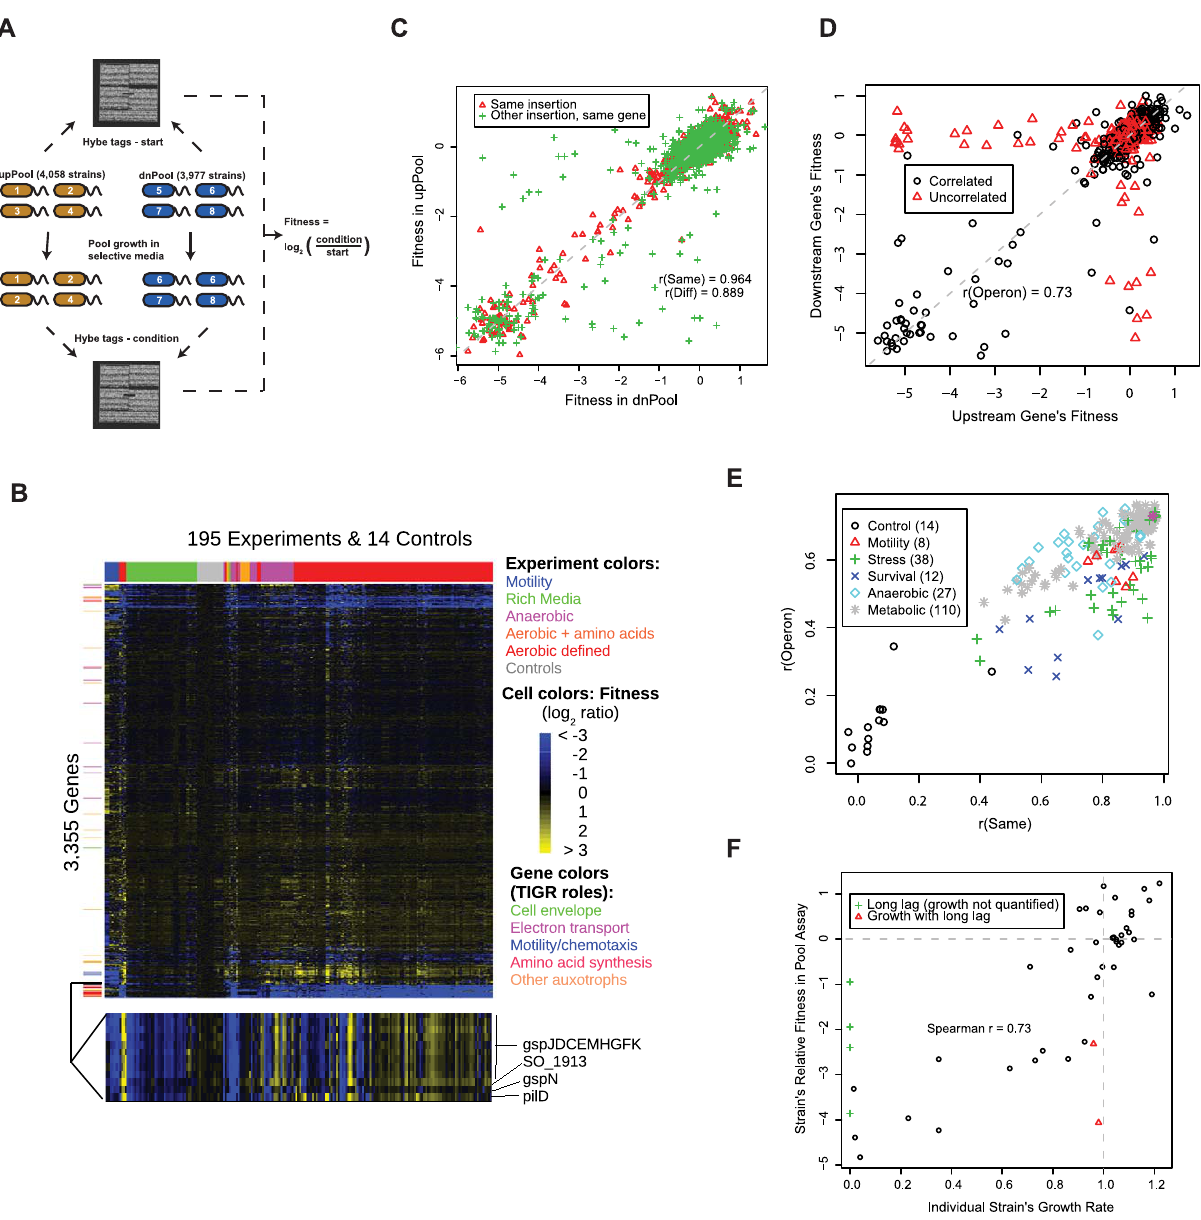
Figure 1. A S.oneidensis MR-1 mutant fitness compendium. (A) Parallel analysis of MR-1 mutant pools using TagModules. Only the uptags are used to interrogate strain abundance in the upPool, while the downtags are used exclusively to measure strain abundance in the dnPool. The Affymetrix TAG4 microarray illustrated here contains the complement sequences to both the uptags and downtags, therefore the abundance of all strains across both pools is assayed in a single hybridization. In the simple example diagrammed here, strain 3 in the upPool and strain 5 in the dnPool have fitness defects. We hybridize the tags both before (start) and after growth in selective media (condition). We calculate the fitness of a strain as the normalized log 2 ratio of tag intensity of the condition relative to start. (B) Heatmap of the entire fitness dataset. Both genes and experiments were ordered by hierarchical clustering with Euclidean distance as the metric. A subset of the fitness heatmap for mutants in the general secretory pathway is expanded (bottom). (C) Fitness values for dnPool strains (x-axis) and upPool strains (y-axis) on DL-lactate defined media. ‘‘Same insertion’’ indicates identical mutant strains that are represented in both pools; ‘‘Other insertion, same gene’’ indicates independent transposon insertions in the same gene. The dashed line shows x=y. (D) Comparison of gene fitness values for pairs of genes predicted to be in the same operon [50]. The data plotted reflects a single fitness experiment in DL-lactate minimal media, but the color-coding is derived from the entire fitness compendium: points in red are uncorrelated (r , 0.3) across 195 fitness experiments. (E) Quality metrics for each of the 195 pool fitness experiments. r(Same) is the fitness correlation of identical mutant strains contained in both the upPool and dnPool (see red triangles in panel C). r(Operon) is the fitness correlation of adjacent genes predicted to the in the same operon (see panel D). (F) Comparison of DL-lactate minimal media pool fitness values (y-axis) and individual strain growth rates (x-axis) for 48 transposon mutants. Individual strain growth rates represent the average of at least three independent experiments. The vertical dotted line represents the growth rate of wild-type MR-1. The horizontal dotted line represents a pool fitness value for a neutral insertion. Some strains had long lag phases and a growth rate could not be calculated (green plus symbols).